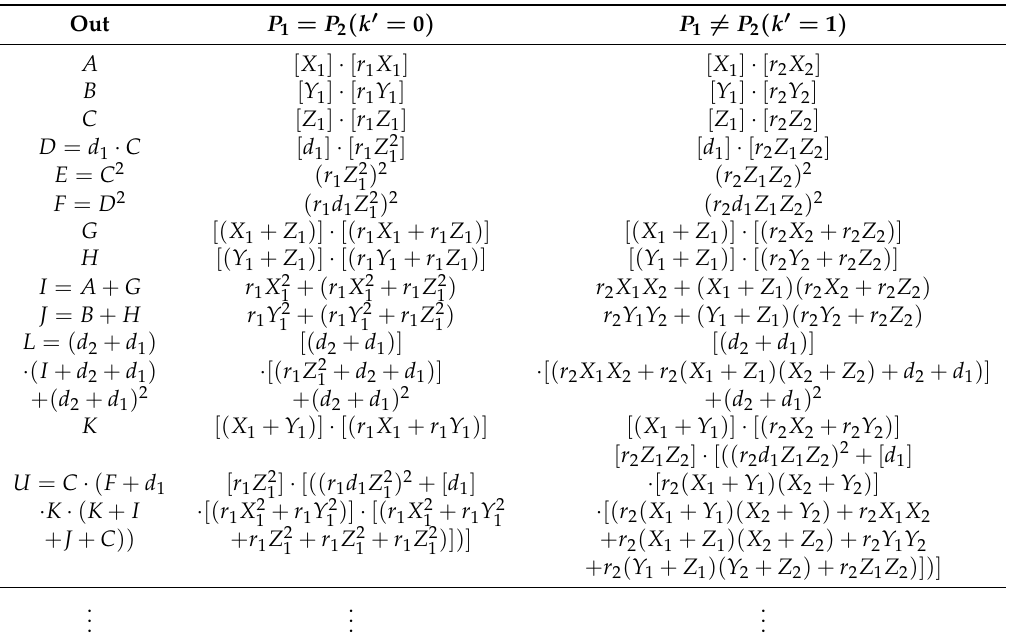
Table A7. The proposed unified point addition method on the binary Edwards elliptic